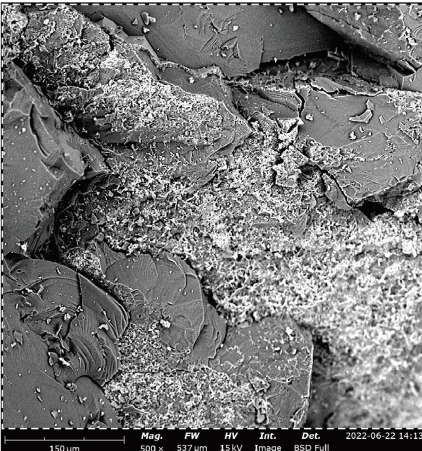
Figure 21: SEM for control sample 800 ° C.